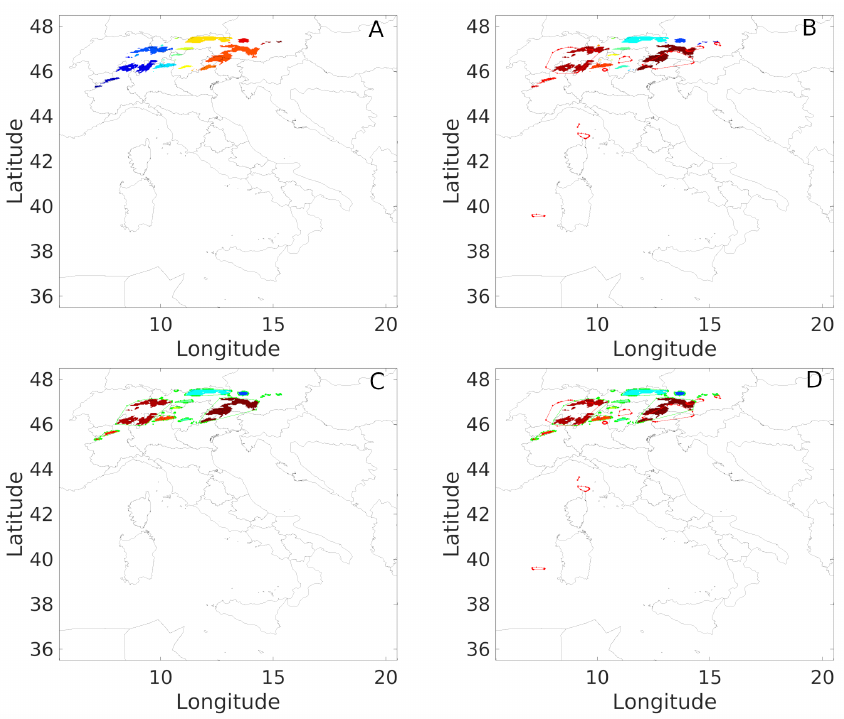
Figure 5. SWING procedure on modeled objects: Panel ( A ) modeled objects, Panel ( B ) grouped modeled object over observed convex hulls, Panel ( C ) modeled convex hulls, Panel ( D ) observed and modeled convex hulls comparison.